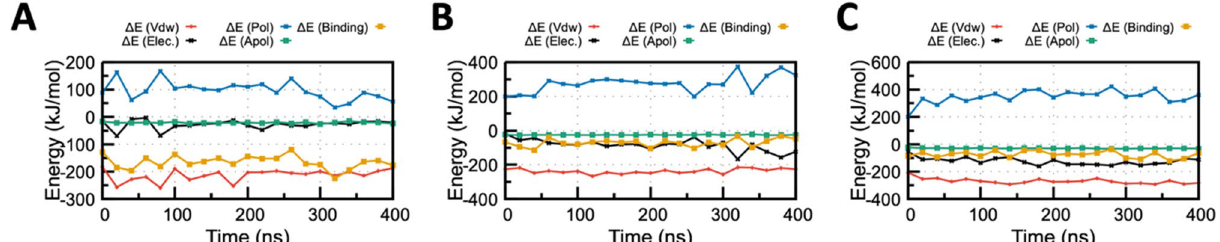
Figure 5. MM/PBSA binding energy profile for the ( A ) ACE2-Grazoprevir ( B ) TMPRSS2-Grazoprevir and ( C ) RdRP-Grazoprevir complex. Contributions from various energy components are also shown for all the three complex. Van der Waals energy (ΔE vdW ), Electrostatic energy (ΔE Elec ), Polar solvation energy (ΔE pol ) , Apolar solvation energy (ΔE Apol ), Total binding energy (ΔE Binding ) are displayed by red, black, blue, green and orange curve